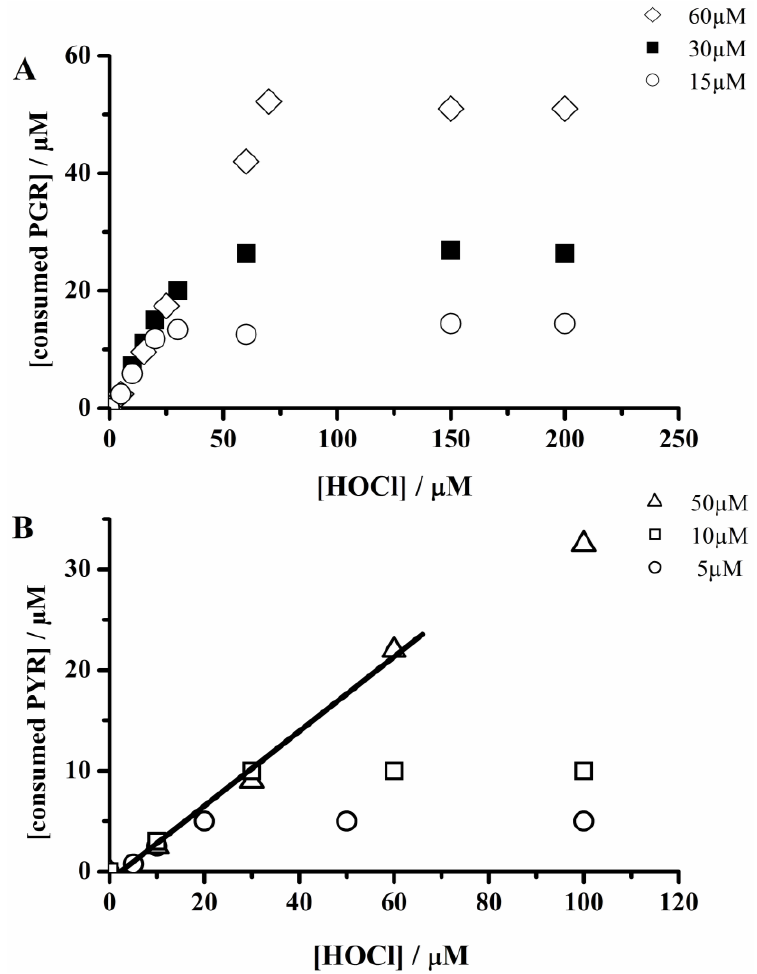
Figure 3. Dependence of the consumed probe with hypochlorite concentration. ( A ) Dependence of the PGR consumed with hypochlorite concentration. [PGR] = 15; 30; and 60 µM. ( B ) Dependence of PYR consumed with hypochlorite concentration. [PYR] = 5; 10; and 50